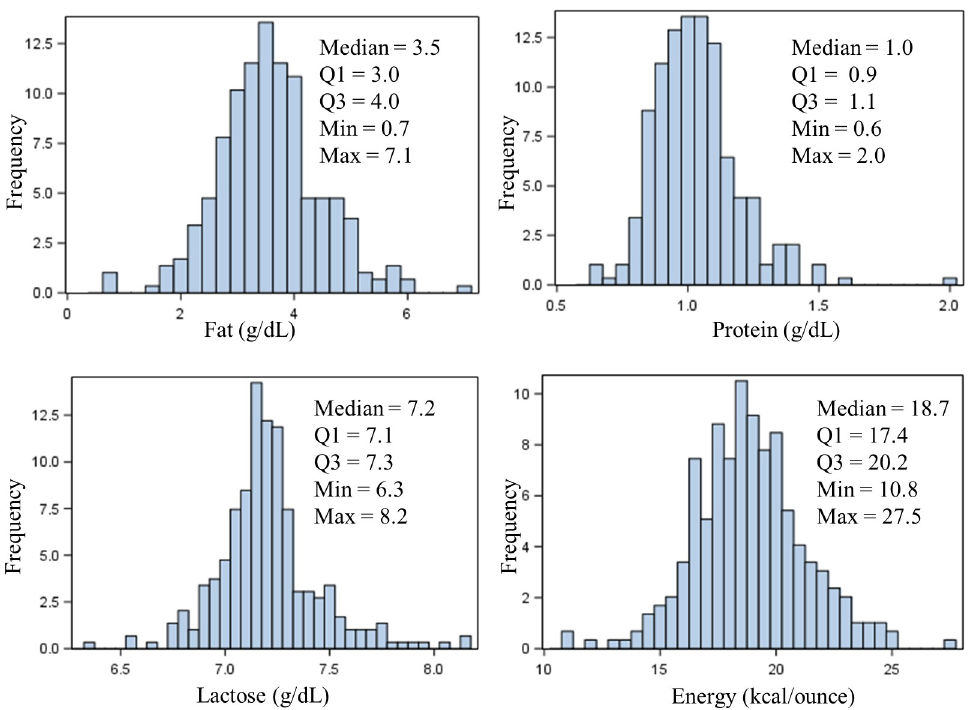
Fig 1. Histograms and descriptive statistics for donor pools. Represents Donor Pools > 4 weeks postpartum from 295 unique donors.